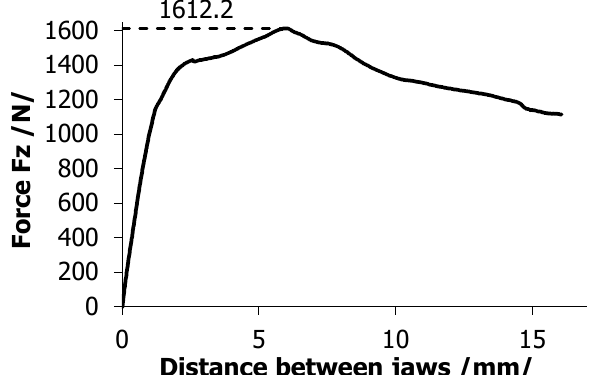
Figure 17. Experiment — Tensile force Fz (N) vs. separation of jaws (mm).